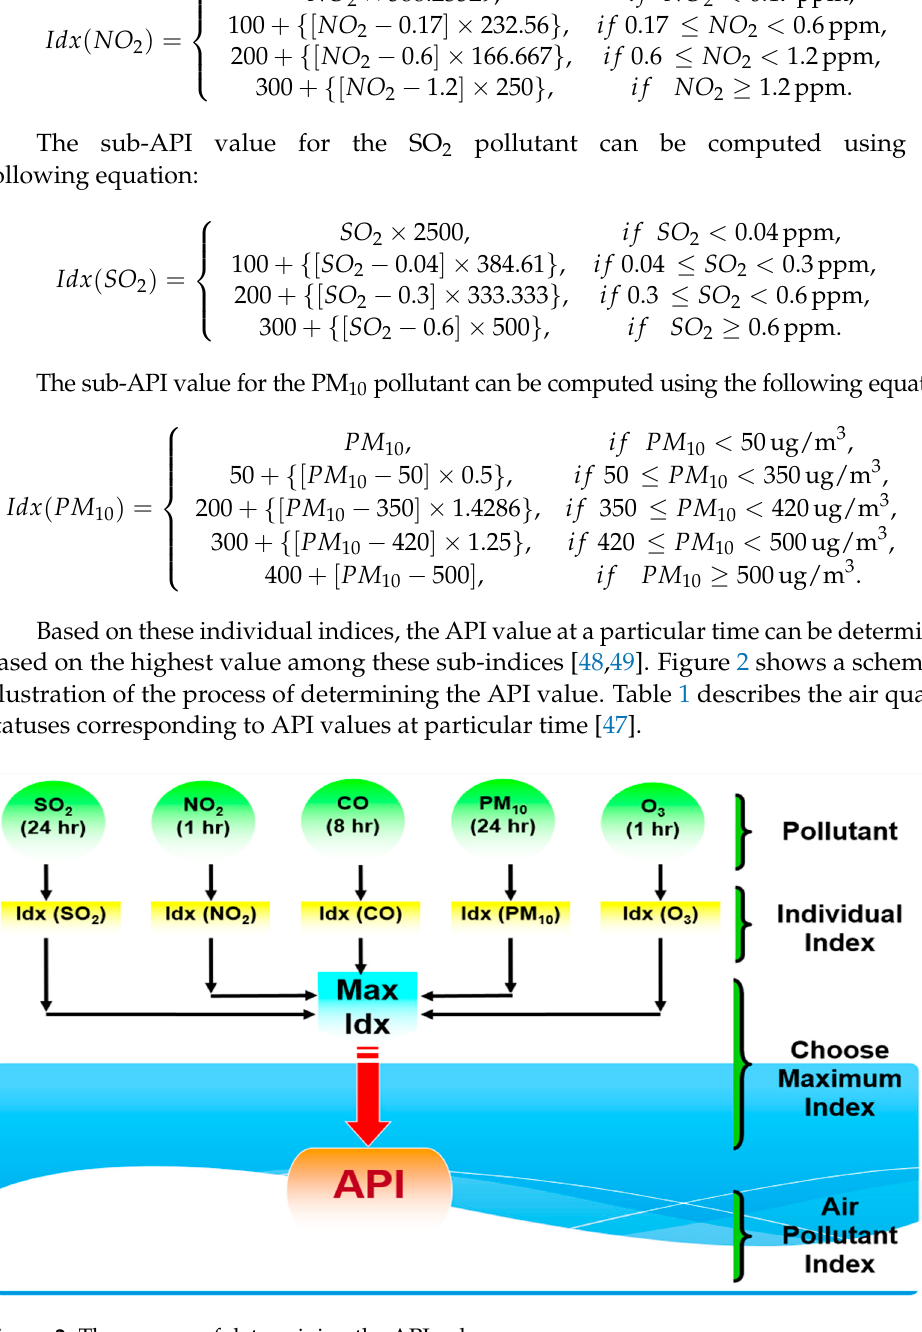
Figure 2. The process of determining the API value.